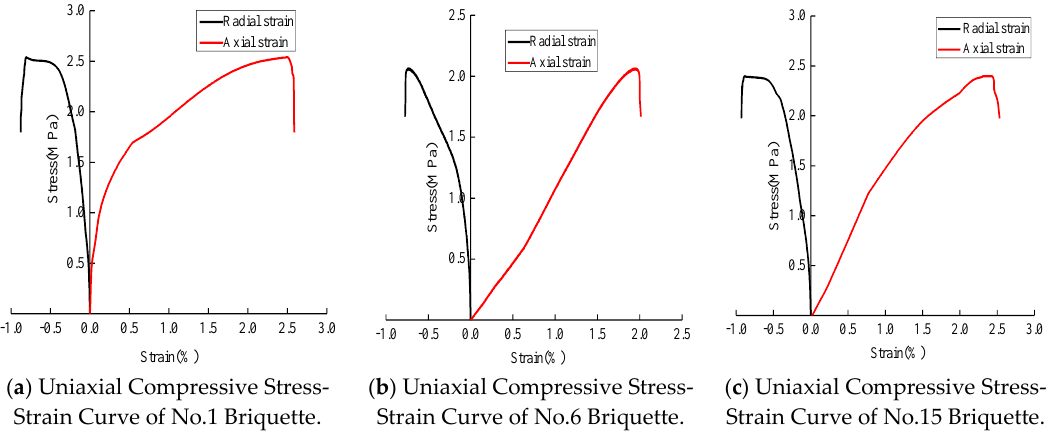
Figure 5. Uniaxial compression stress – strain curve.